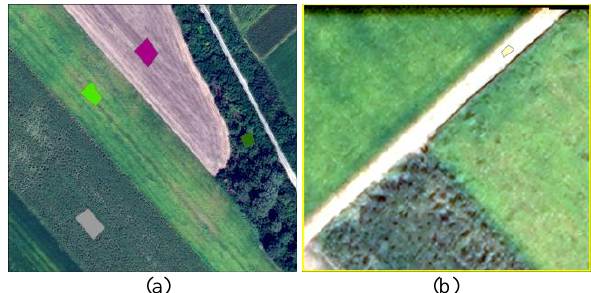
Figure 6. Sample training polygons defined on MAXAR image of Novi Sad test site with locations shown on Figure 5. (a) vegetation-1, vegetation-2, vegetation-3, wooded area, (b) road. In the training and test data collection stage, tile-1 (top right tile in Figure 3) was used in Gibraltar test site as it included samples for all classes. The test data was collected from all tiles in Gibraltar. In total of 470,328 training data samples